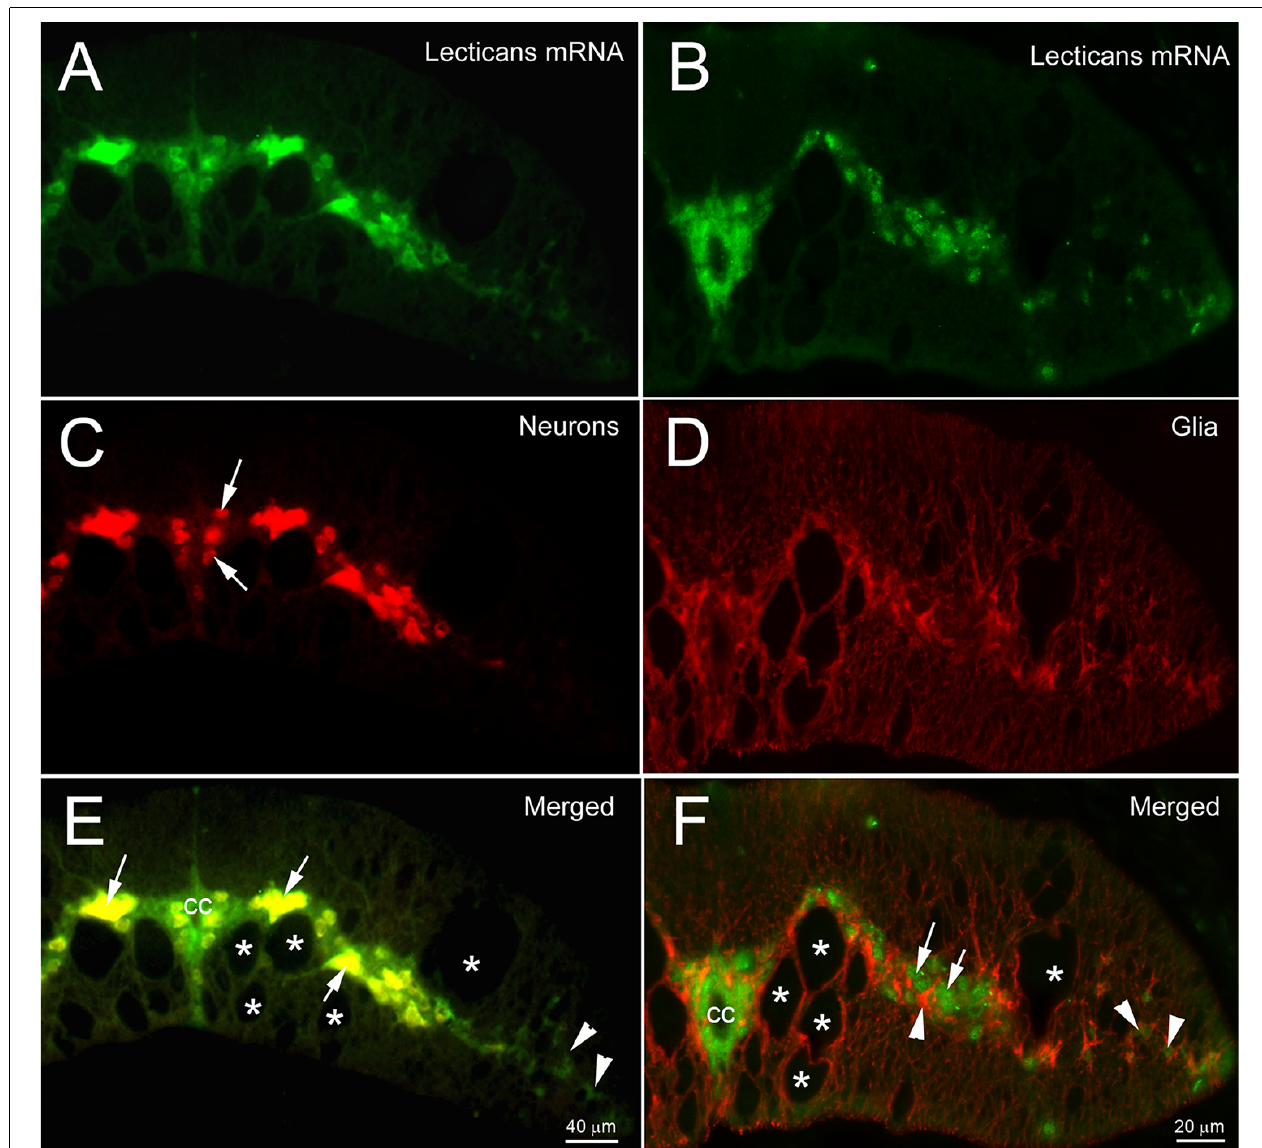
FIGURE 3 | Expression of lectican mRNAs in neurons and glia. Transverse sections of lamprey spinal cord are double labeled by lectican ISH, using probe 1 (A,B) and by anti-Hu, an antibody specific for neuronal cell bodies (C) , or LCM29, an antibody for glial keratins (D) that labels glial cell bodies and processes. Arrows in (C) point to cerebrospinal fluid (CSF)-contacting neurons. (E,F) Overlayed images show the expression of lectican mRNAs in neurons (arrows in E and F ) and glia (arrowheads in E and F ). cc = central canal. Asterisks = giant axons (Müller axons in the ventromedial white matter and the more dorsolateral Mauthner